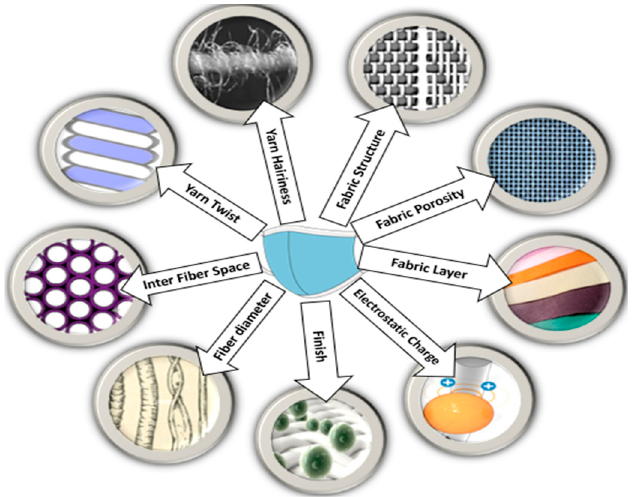
Figure 4. Factors affecting the development and filtration performance of reusable face coverings.